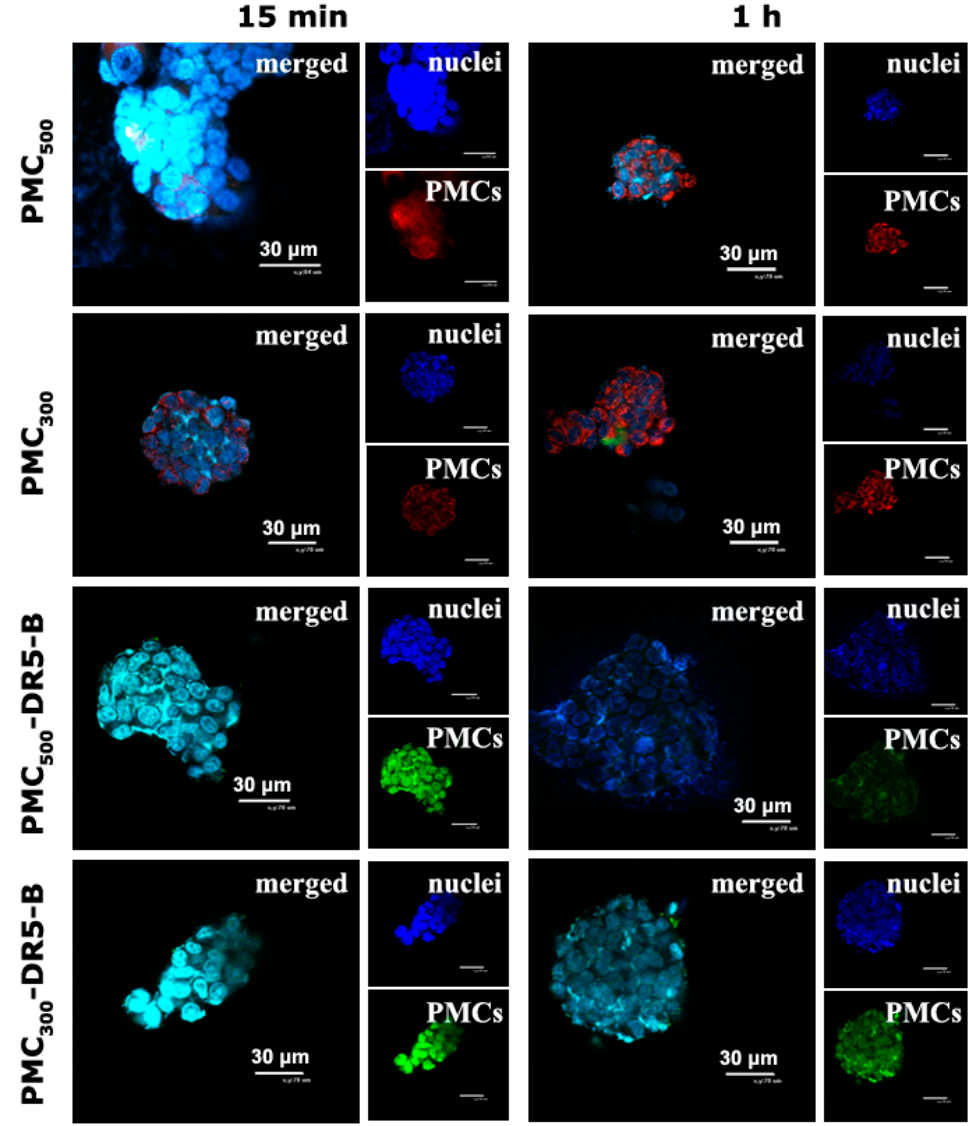
Figure 5. Spheroids from human colorectal carcinoma HCT116 cells (multicellular tumor spheroids) after 15 min and 1 h incubation with PMC 500 and PMC 300 samples. The unmodified PMC are stained with R6G rhodamine (in red) and the DR5-B is stained with a BDP FL maleimide dye (in green). Cell nuclei are stained with Hoechst 33258 (in blue). Confocal microscopy. The scale bar is 70 µm.